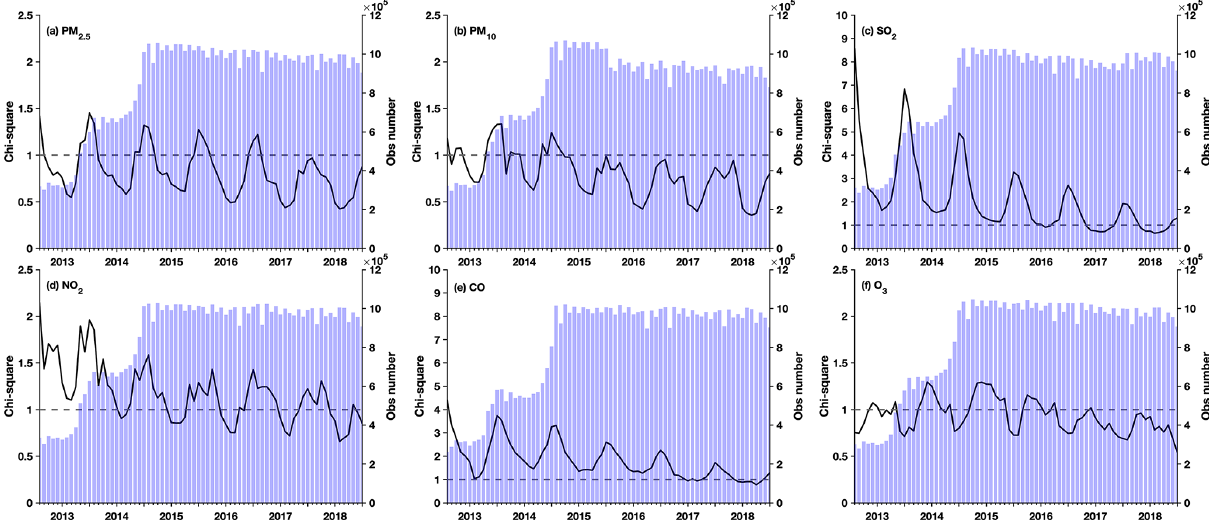
Figure 3. Time series of the monthly mean χ 2 values (black line) and the number of assimilated observations per month (blue bars) for (a) PM 2 . 5 , (b) PM 10 , (c) SO 2 , (d) NO 2 , (e) CO, and (f) O 3